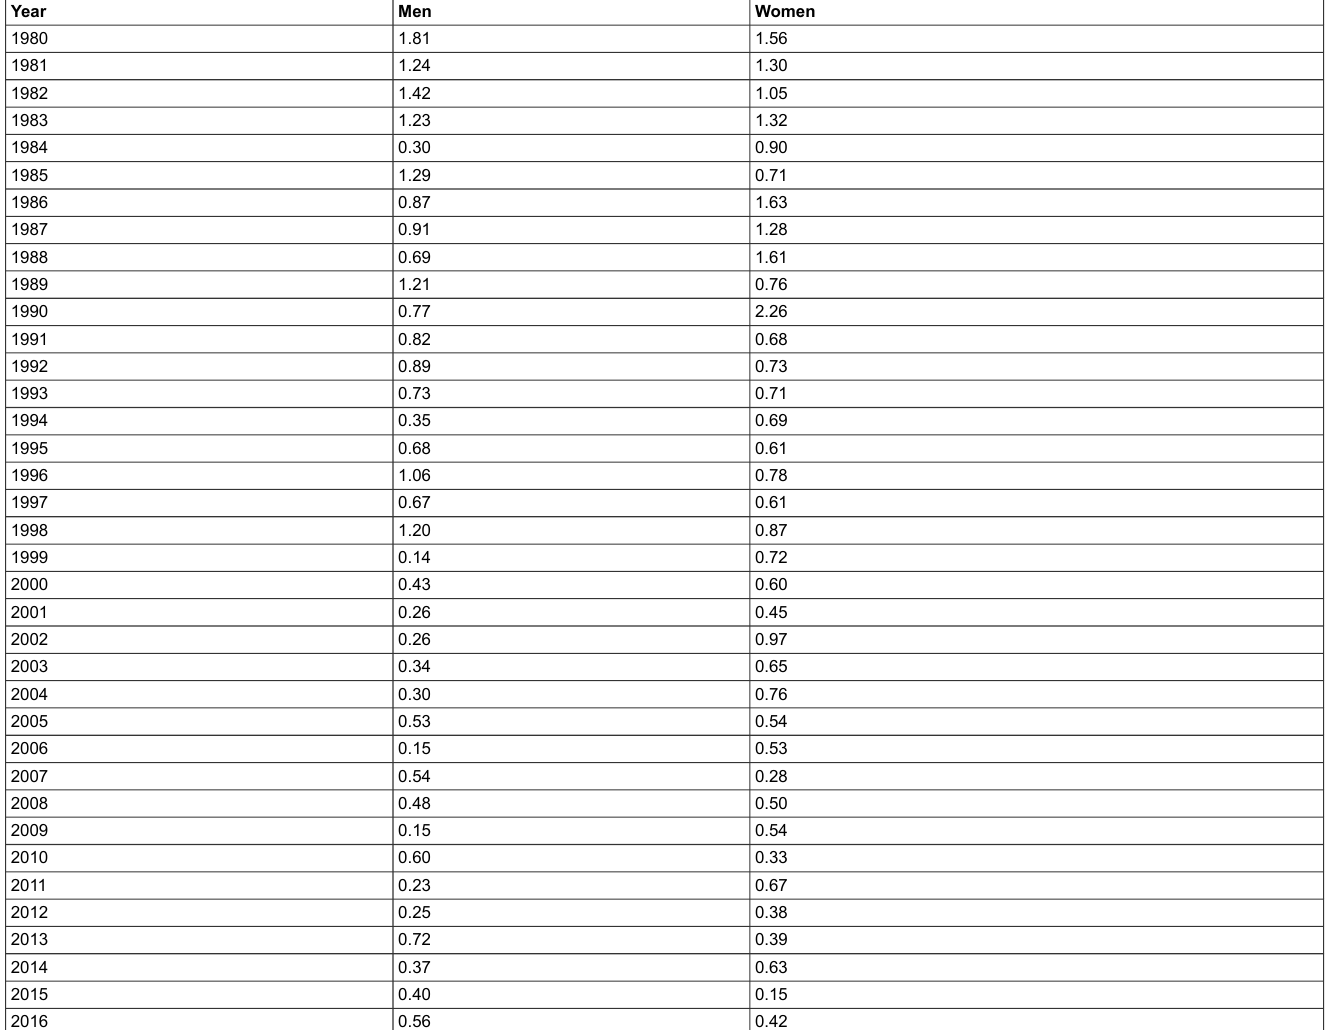
Table S2: Thyroid cancer mortality rates by sex in the canton of Zurich 1980–2016. Age-standardised rate (European population) per 100,000 persons. Year Men